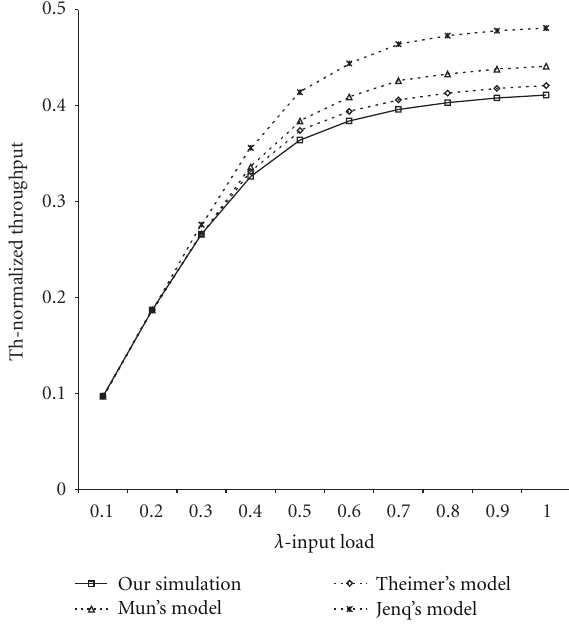
Figure 4: Normalized throughput of a single bu ff ered 6-stage MIN.